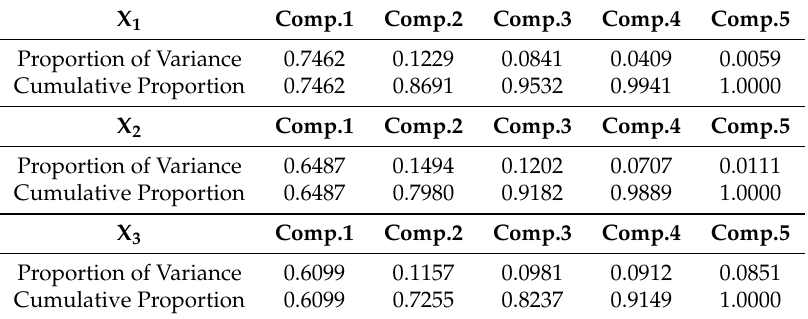
Table 3. Principal component analysis (PCA) with the simulated multivariate data. X 1